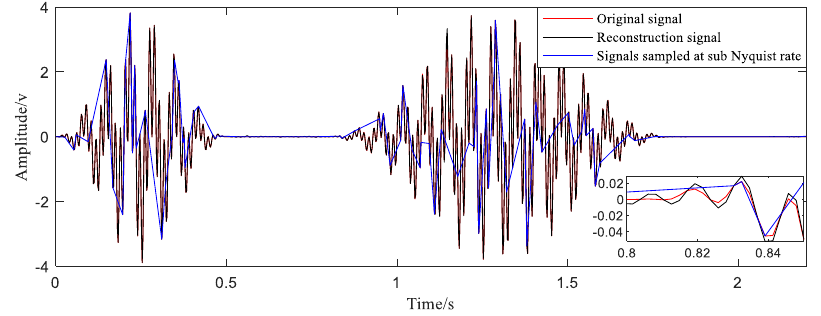
Figure 7. Comparison between reconstructed signal and original signal.